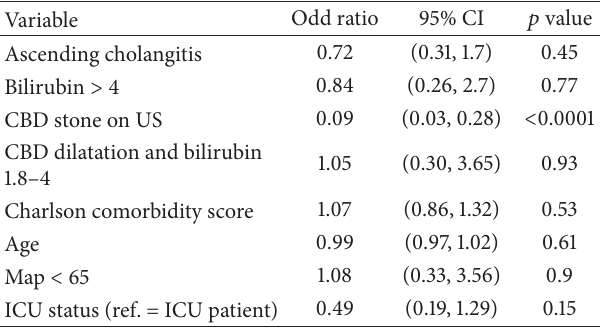
Table 3: Multivariable analysis of predictors of MRCP use in patients at high risk of